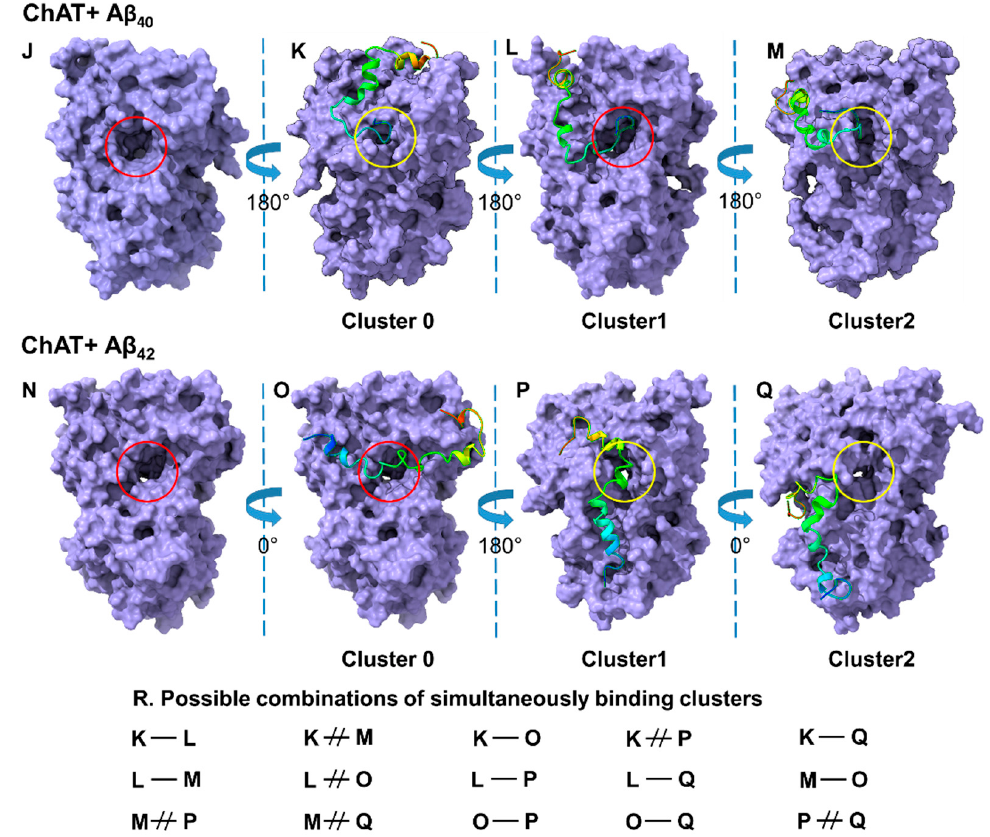
Figure 9. The most stable energy minima conformers of ChAT-A β complexes. The outlined struc- tures represent the Lowest Energy Minima conformers, i.e., the energetically favored complexes, constructed based on the free-energy landscape analysis as a function of root mean square deviation (RMSD) and radius of gyration (RoG) of ChAT-A β clusters. ( J , N ) show the 3D representation of ChAT protein, where the choline entrance of the catalytic tunnel is indicated by a red circle . ( K – M ) show the Lowest Energy Minima conformers of the most probable binding-site clusters-0, -1 and -2 of A β 40 peptides, respectively. The yellow circle highlights the Acetyl-CoA-entrance of the catalytic tunnel. A comparison of ( K – M ) indicates that the binding of A β 40 at cluster-1, but not cluster-0 or -2, will most likely block the entrance of choline into the catalytic tunnel of ChAT. ( O – Q ) illustrate the Lowest Energy Minima conformers of the most probable binding-site clusters-0, -1, and -2 for A β 42 peptide, respectively. Similar to A β 40 , one out of the top three clusters of A β 42 (cluster-0) also overlaps the choline-entrance site of the catalytic tunnel ( O ). The table ( R ) shows all possible/excluding combinations if two A β peptides bind to one ChAT molecule simultaneously. For example, the cluster-0 ( K ) will most likely exclude simultaneous binding of another peptide at cluster-2 ( M ) or vice versa. This is denoted as K ≠ M. In contrast, it is possible for two A β 42 peptides to bind simultaneously